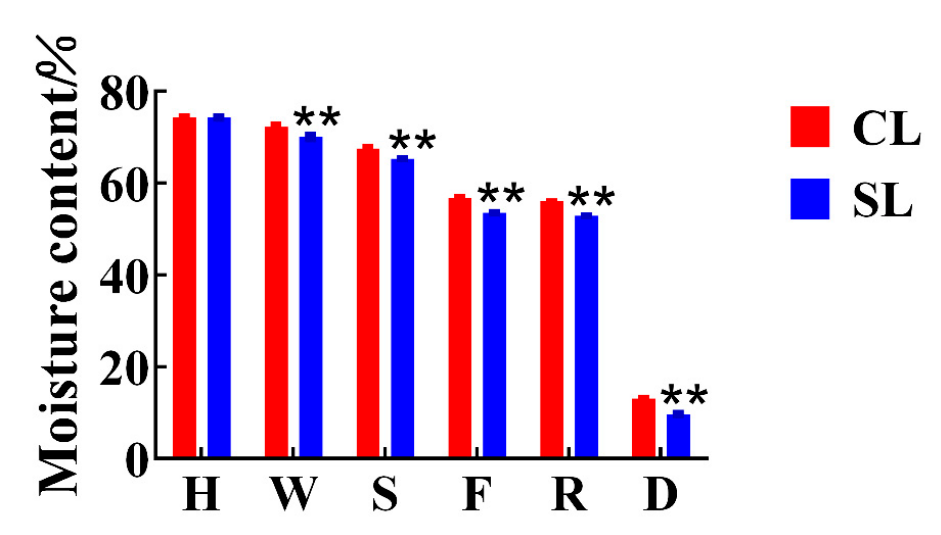
Figure 3. Changes in moisture content during oolong tea processing. H stands for harvesting, W stands for withering, S stands for shaking, F stands for firing, R stands for rolling, and D stands for drying (CL, combined leaf; SL, separated leaf; **, p < 0.01).